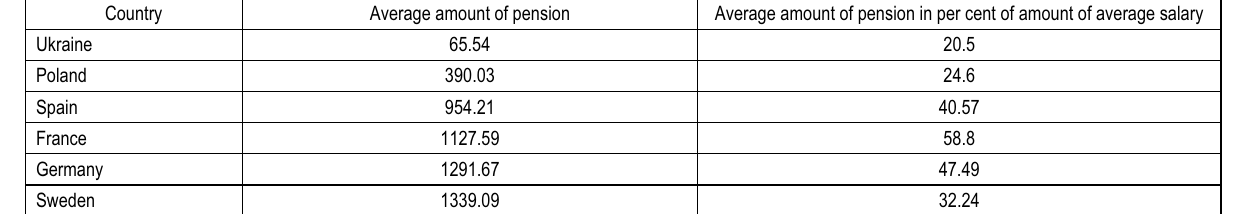
Table 2. Average amount of pension in Ukraine and some European countries in 2015 Country Average amount of pension Average amount of pension in per cent of amount of average salary